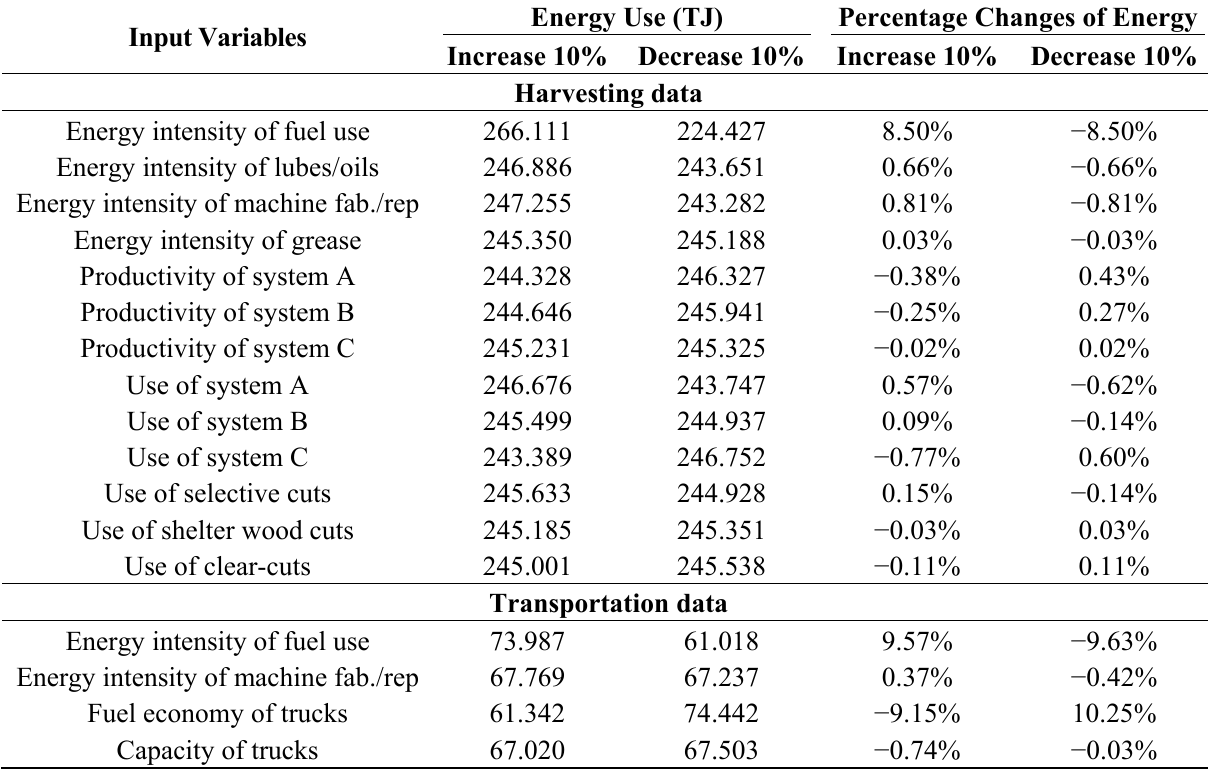
Table 10. Resulting changes in energy use for harvesting or transport operations by increasing or decreasing input variables by